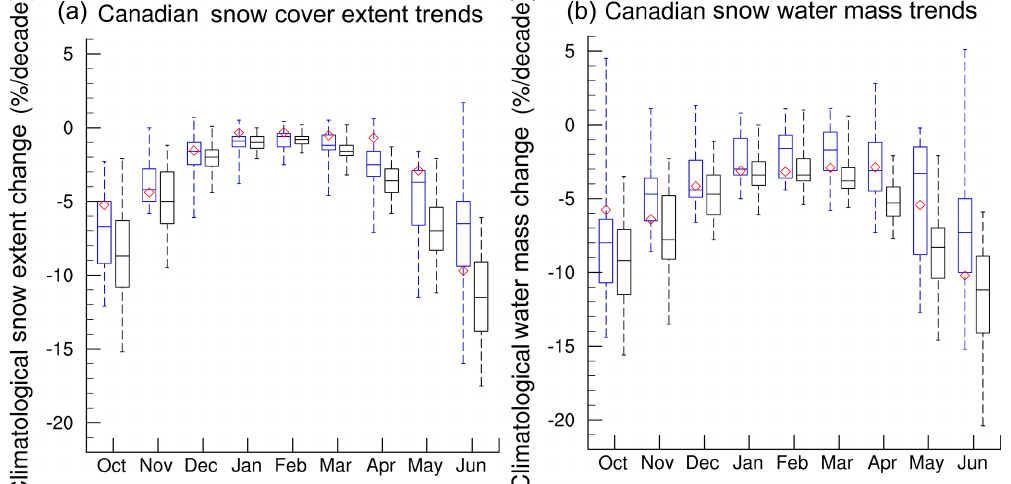
Figure 11. 2020–2050 monthly trends in Canadian snow cover extent (a) and snow water mass (b) from the CMIP5 multi-model ensemble (blue) and CanESM large initial condition ensemble (black). Monthly mean observational trends (1981–2015) from the snow dataset used in Sect. 2 are shown in red. For each box the enclosed region shows the 25–75th percentile range, the horizontal line shows the median, and the dashed whiskers illustrate the minimum and maximum.